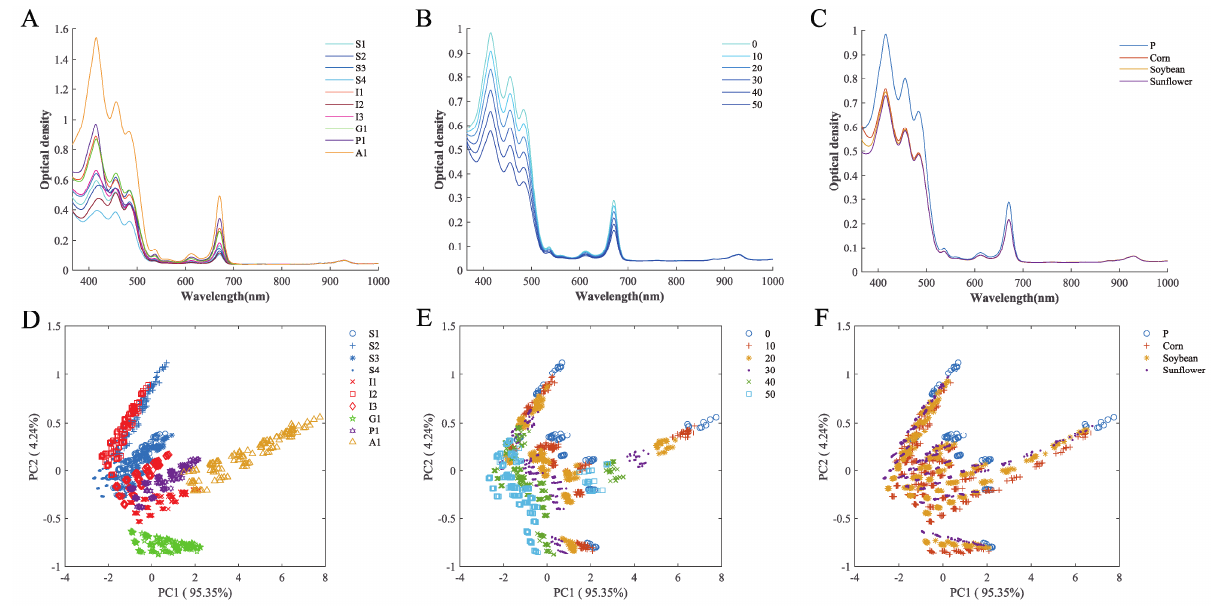
Figure 2. Mean UV-Vis spectral profile ( A – C ) and conventional PCA score plots ( D – F ) of adulter- ated olive oil according to different factors. ( A , D ) EVOO Origin; ( B , E ) Adulteration Level; ( C , F ) Adulteration Type. EVOO Origin included Spain, S1–S4; Italy, I1–I3; Greece, G1; Portugal, P1;